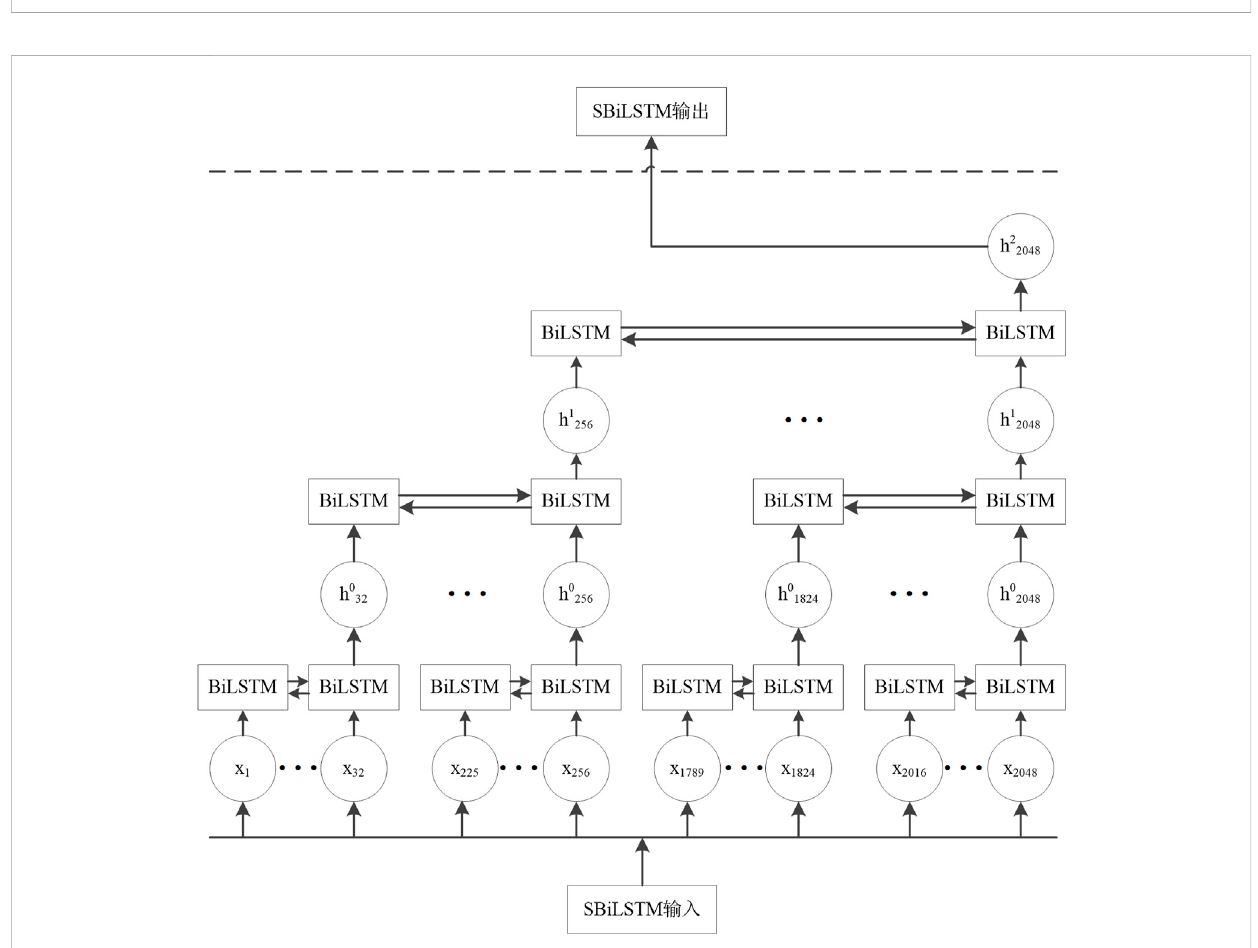
FIGURE 3 The structure of SBiLSTM